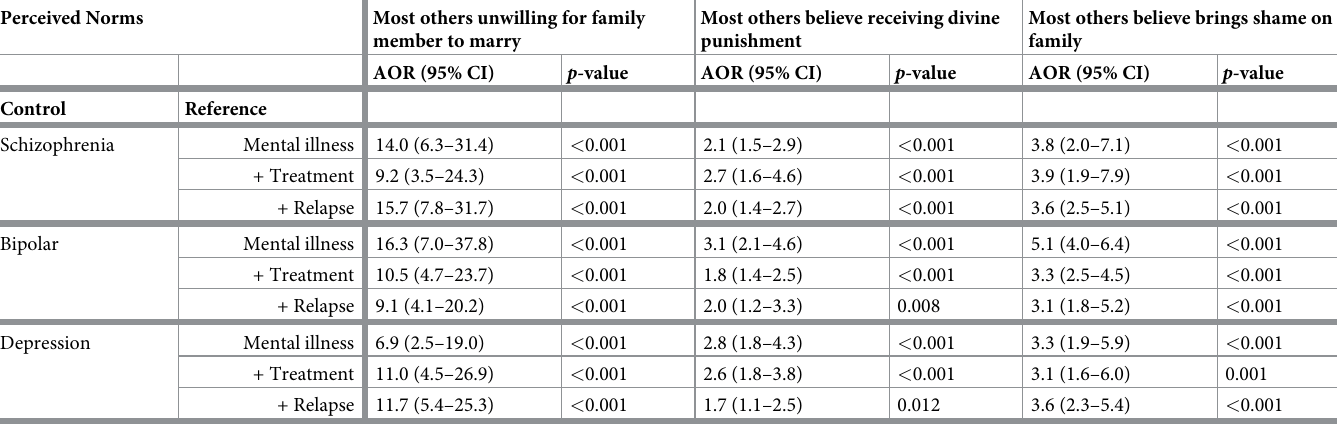
Table 5. Odds of perceiving stigmatizing beliefs of others by treatment assignment based on ordered logit regression. Perceived